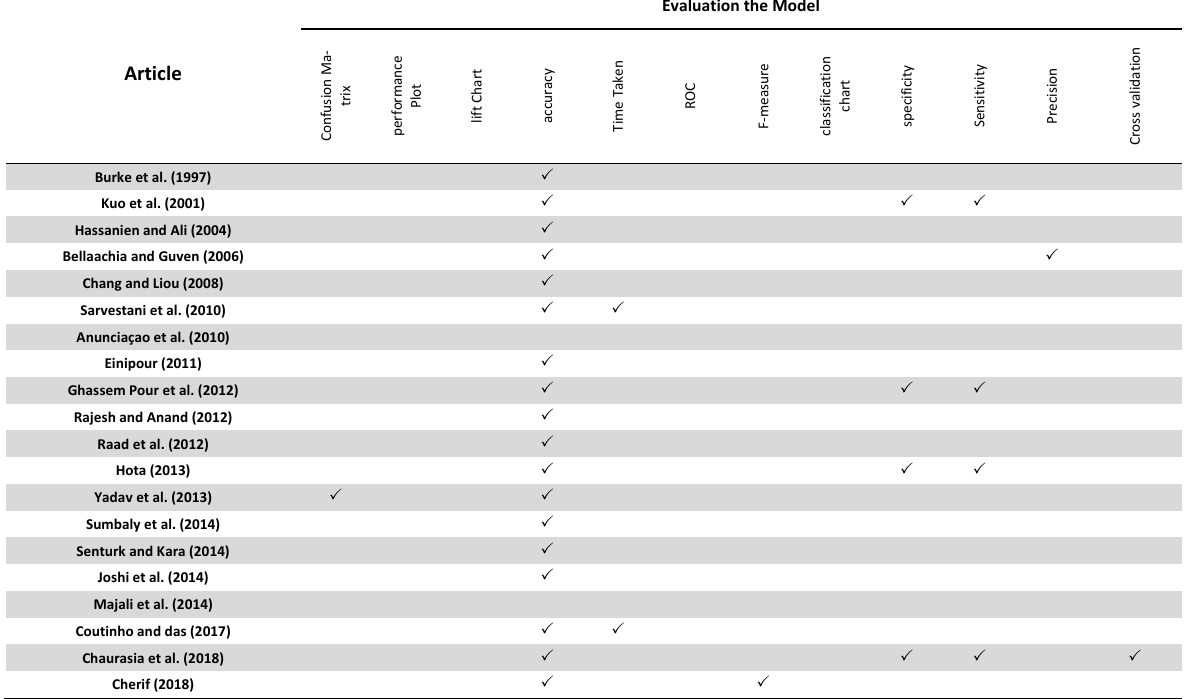
The overall review of the evaluation